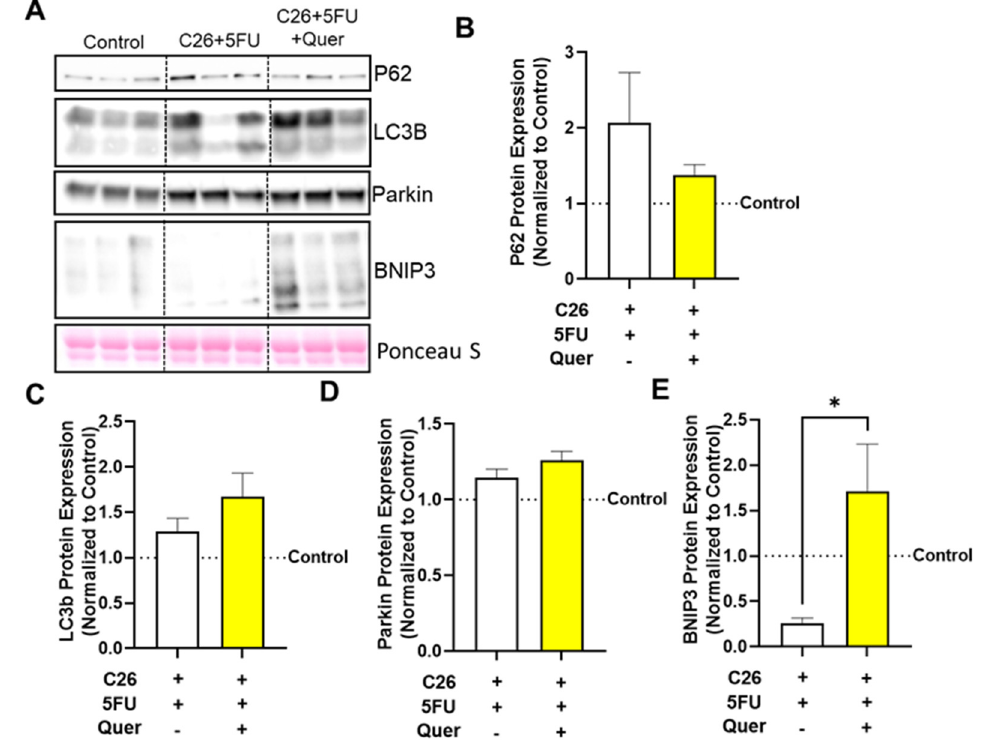
Figure 5. Quercetin has modest impacts of general autophagy and mitophagy proteins. ( A ) Representative Western blots of P62, light chain 3 (LC3B), Parkin, Bcl ‐ 2 interacting protein 3 (BNIP3), and loading control Ponceau S from the rectus femoris muscle. Vertical dotted line demonstrates where images were cropped for representation. All samples were run on the same gel/membrane. Quantified relative expression of ( B ) P62, ( C ) LC3B, ( D ) Parkin, and ( E ) BNIP3. Unpaired t ‐ test between C26 + 5FU and C26 + 5FU + Quer. n = 3 – 5/group. * p ≤ 0.05.